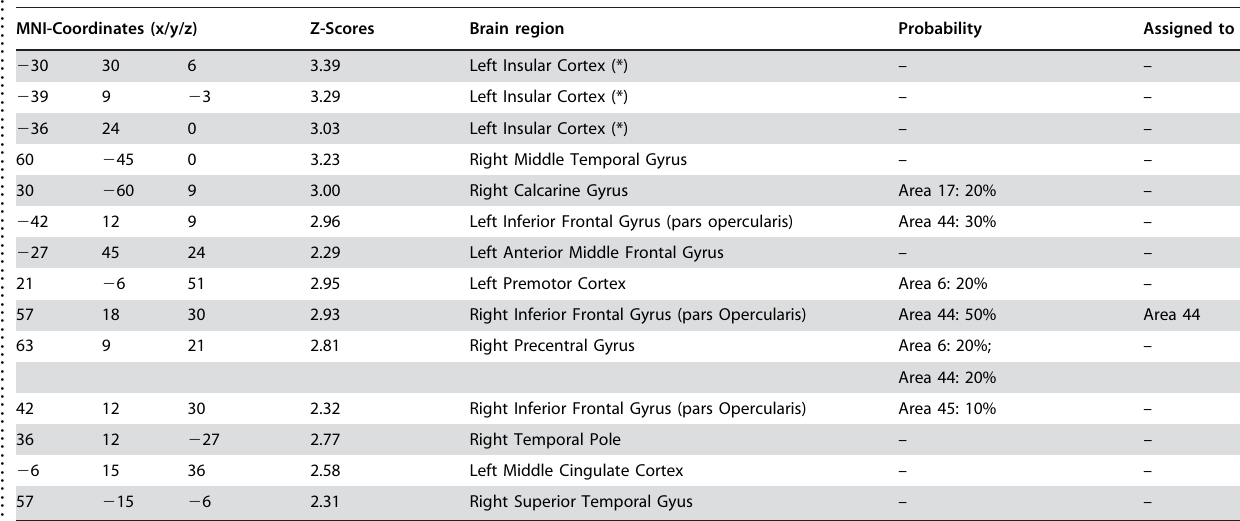
Table 1. For each BOLD signal change, peak MNI-coordinates and z-score are given. .. ... .... ... ... .... ... ... .... ... ... .... ... ... .... ... ... .... ... ... .... ... ... .... ... ... .... ... ... .... ... ... .... ... ... .... ... ... .... ... ... .... ... ... . MNI-Coordinates (x/y/z) Z-Scores Brain region Probability Assigned to